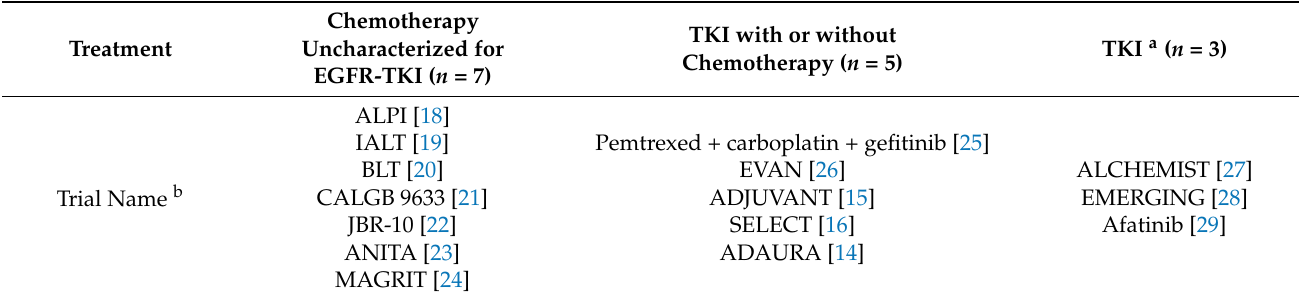
Table 1. Reviewed clinical trials of adjuvant therapy for past trials that were uncharacterized for EGFR, past and present trials involving TKI with or without chemotherapy in completely resected EGFR-mutated